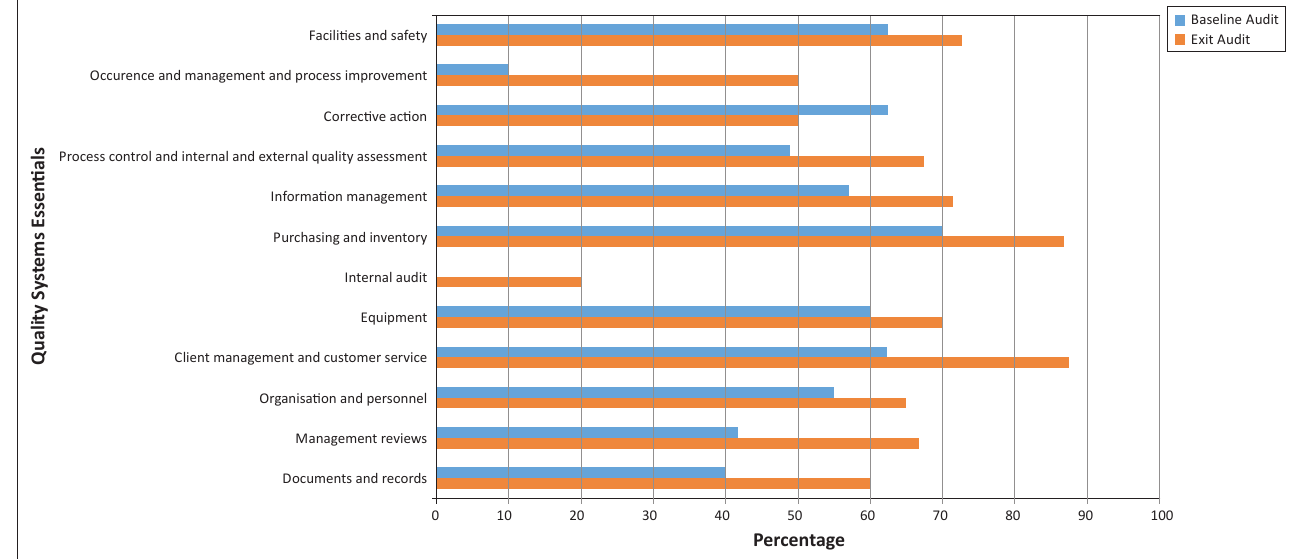
FIGURE 1: SLIPTA scores and star levels at the baseline and exit audits, Botswana SLMTA programme 2010–2011.